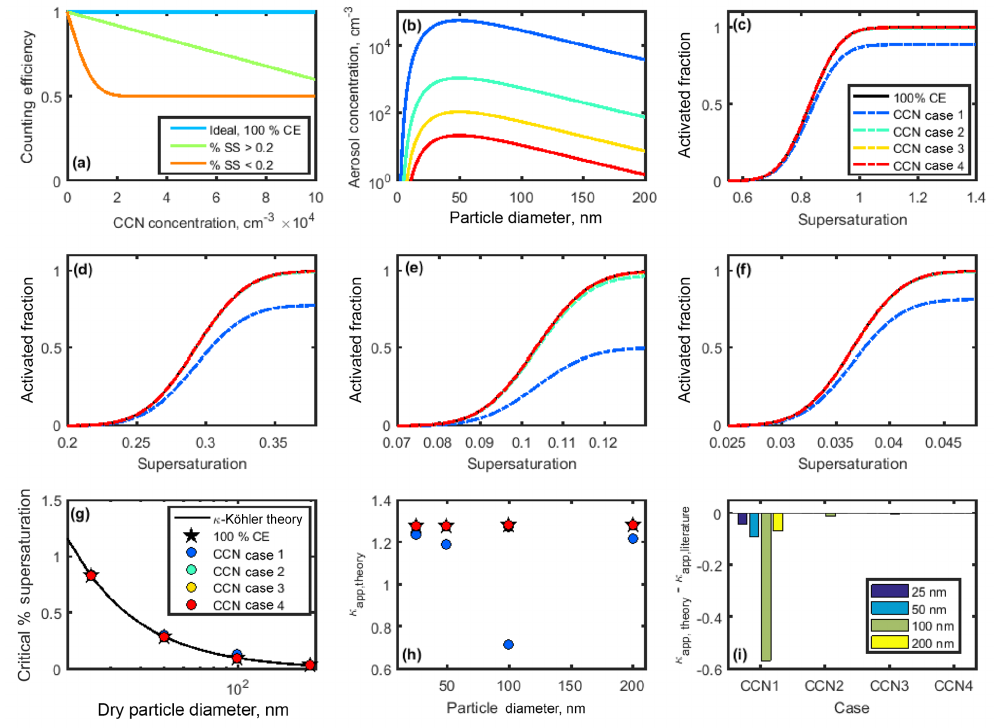
Figure 9. (a) Counting efficiencies of the DMT CCN-100 for specific supersaturations. (b) Lognormal aerosol distributions used to study CCN undercounting at high concentrations. (c–f) Activated fraction curves for 25, 50, 100, and 200nm NaCl particles. Supersaturation- specific counting efficiencies from (a) applied to theoretical sigmoid curves for NaCl CCN activation. Activated fraction in the case of 100% counting efficiency is shown for comparison. (g) Critical supersaturation for each case. (h) Theoretical κ app calculated for each case. (i) Artifacts in κ app artifacts for each